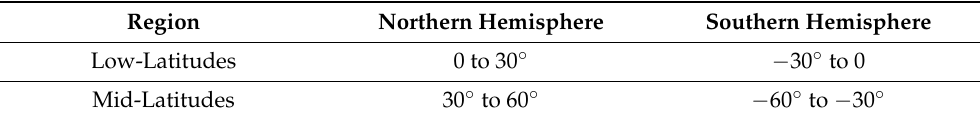
Table 1. Geographic coordinates of low- and mid-latitudes regions. Region Northern Hemisphere Southern Hemisphere Low-Latitudes 0 to 30 ◦ − 30 ◦ to 0 Mid-Latitudes 30 ◦ to 60 ◦ − 60 ◦ to − 30 ◦